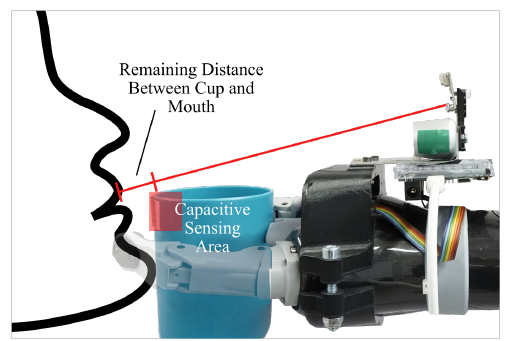
Figure 11. Schematic illustration of the second error